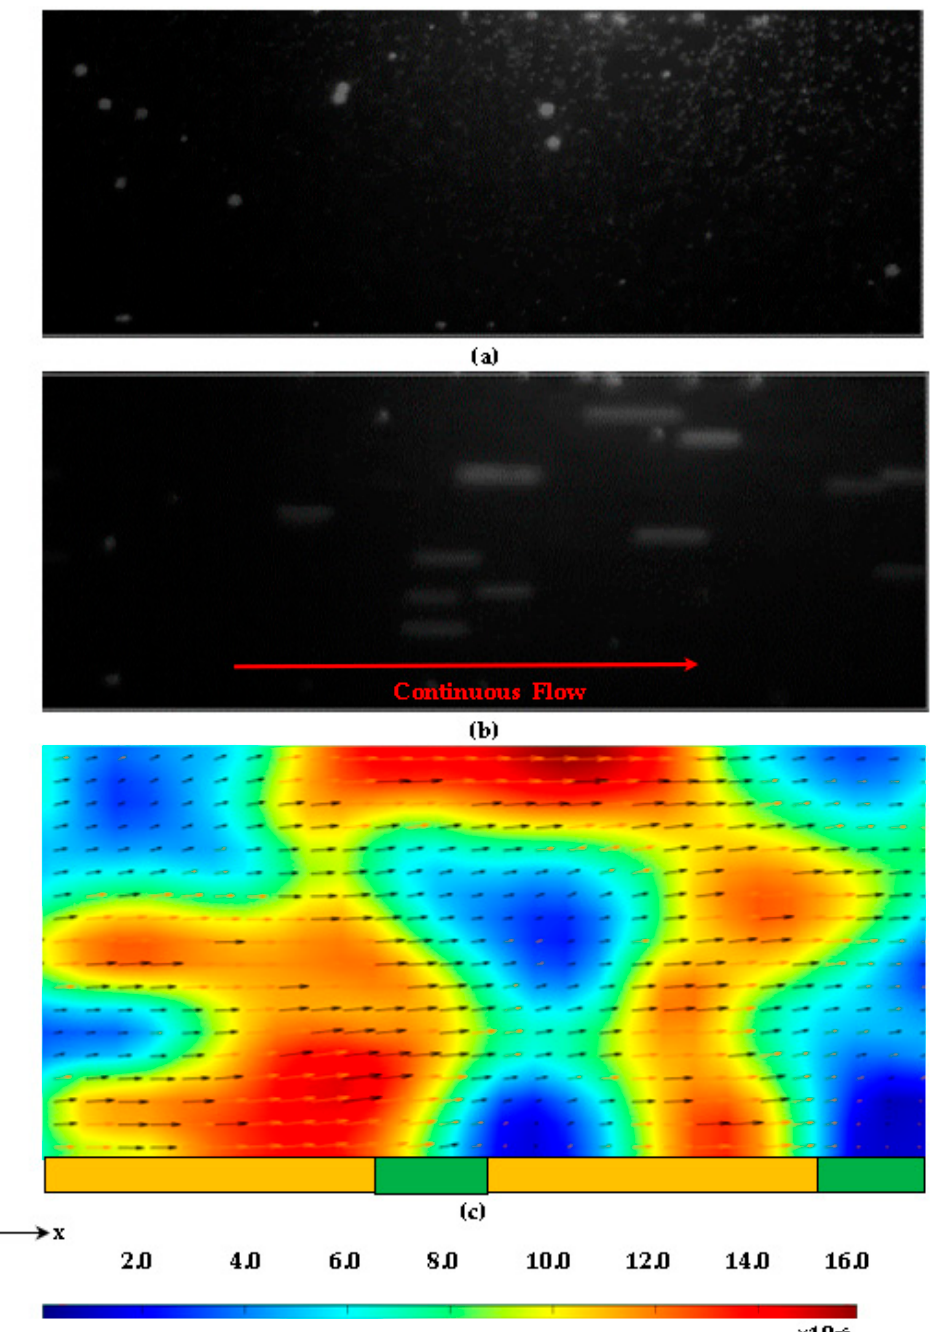
Figure 28. Particle images and contours obtained at 6 A and 10 Hz before and during excitation: ( a ) image of particles randomly dispersed before the field is turned on, ( b ) particle images obtained during excitation, and ( c ) the processed velocity contour of 1 um diameter fluorescent particles at 6 A and 10 Hz.